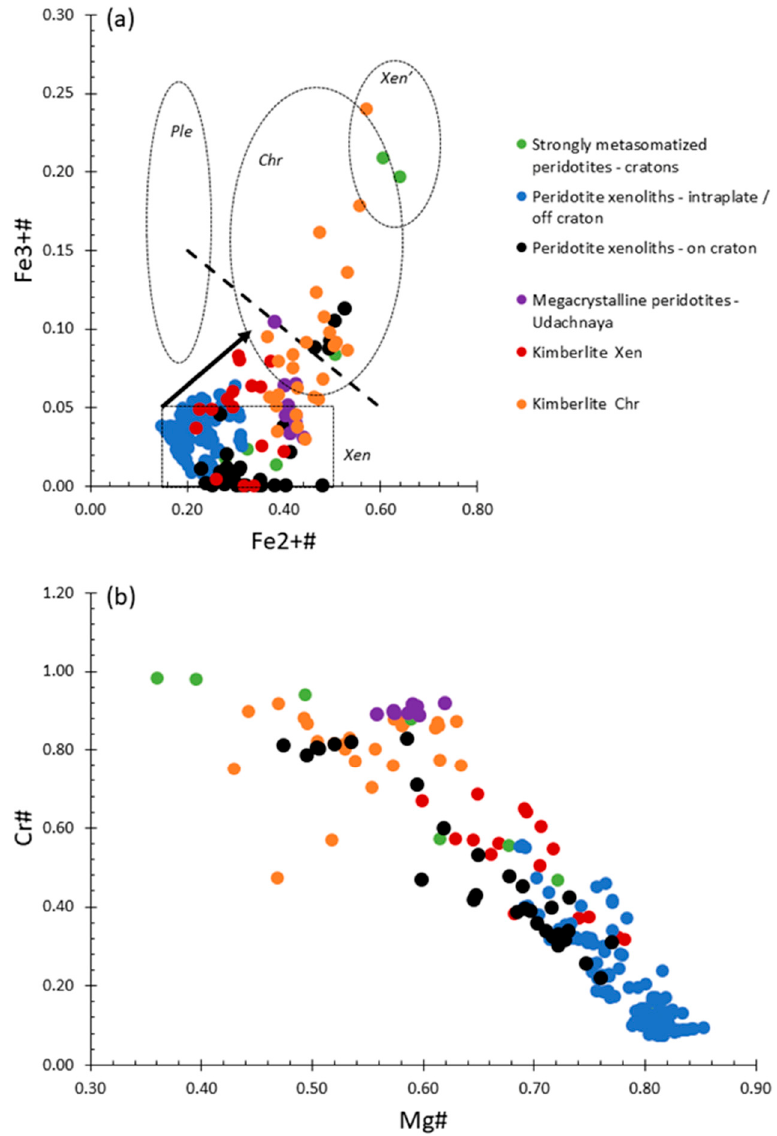
Figure 3. Compositional variations of Cr-spinel grains from this study shown in terms of: ( a ) Fe 2+ / Fe 2+ + Mg (Fe 2+ #) vs. Fe 3+ /Fe 3+ + Cr + Al (Fe 3+ #) and ( b ) Mg/Mg + Fe (Mg#) vs. Cr/Cr + Al (Cr#) projections. Compositional fields and trends (dashed shapes and black arrow) are after Roeder and Schulze (2008) [30]. The dashed line was calculated in this work and we classified as kimberlitic Chr the spinels either with Cr# > 0.75–0.667 × Fe 3+ # or Fe 3+ # = 0.2–0.25 × Fe 2+ #, while the remaining spinels wereclassified as Xen in kimberlite. Data for: strongly metasomatised peridotites from [19]; intraplate peridotite xenoliths from [15–18]; on-craton peridotite xenoliths from [31–33]; megacrystalline peridotites from [13].